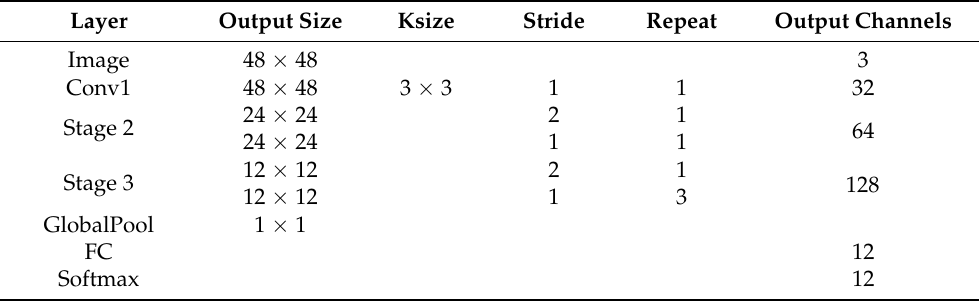
Table 2. Modified ShuffleNetV2 network.